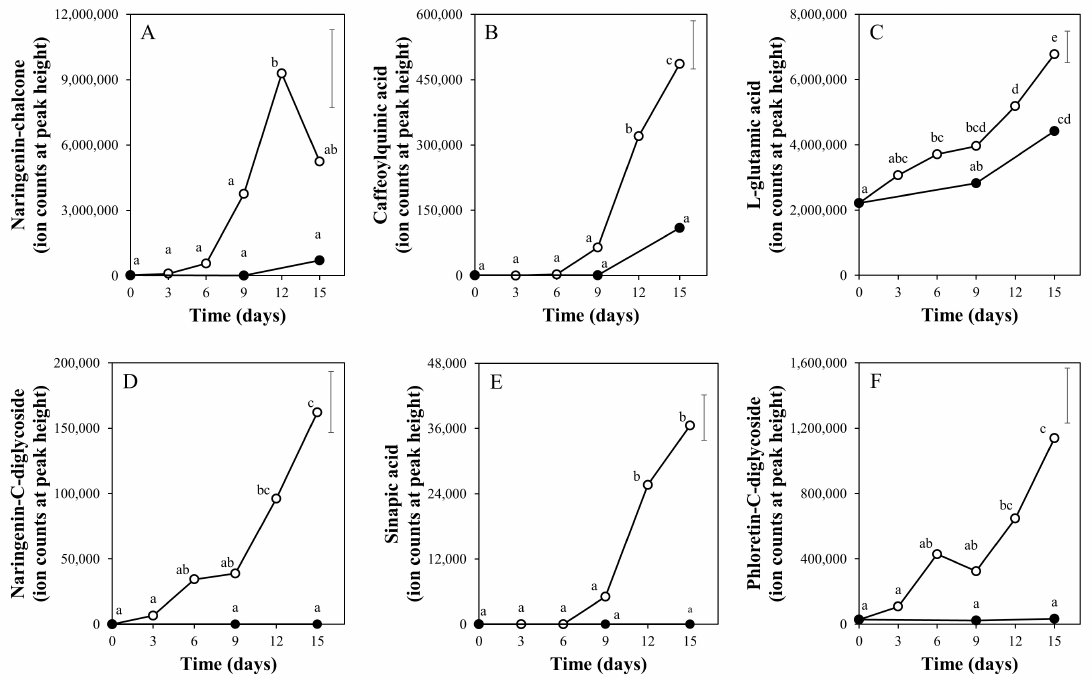
Figure 3. Relative levels of selected metabolites in tomato pericarp from experiment 1, measured by LCMS. The fruits were treated with white light (500 μmol m −2 s −1 ; open symbols) or darkness (closed symbols) for 15 days and sampled at indicated days. Error bars indicate the least significant difference; letters ( A – F ) indicate significant differences between treatments or days at α = 0.01, n = 3 (three pools of two fruits each).